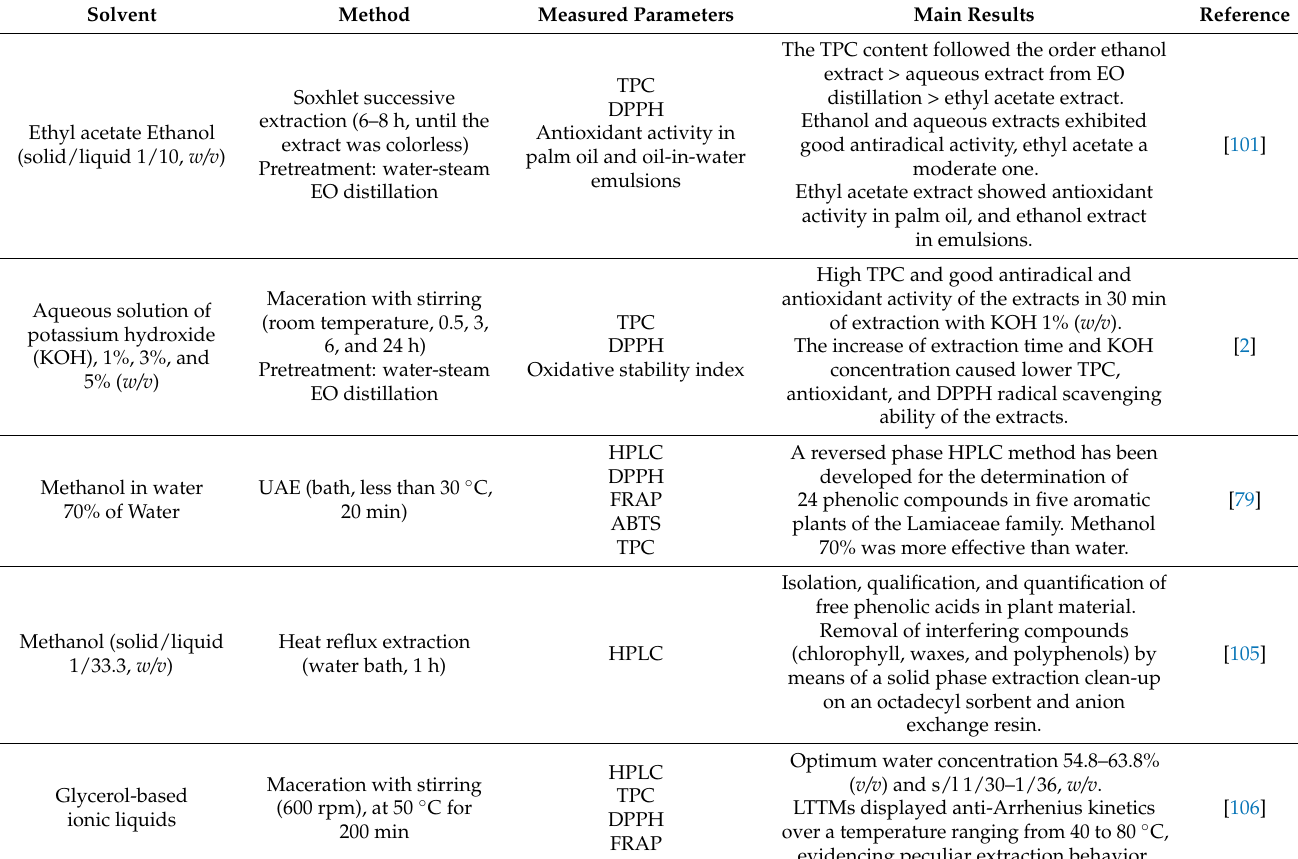
Table 3. Extraction techniques and main results reported in literature for the recovery of phenolic compounds from pink savory. Solvent Method Measured Parameters Main Results